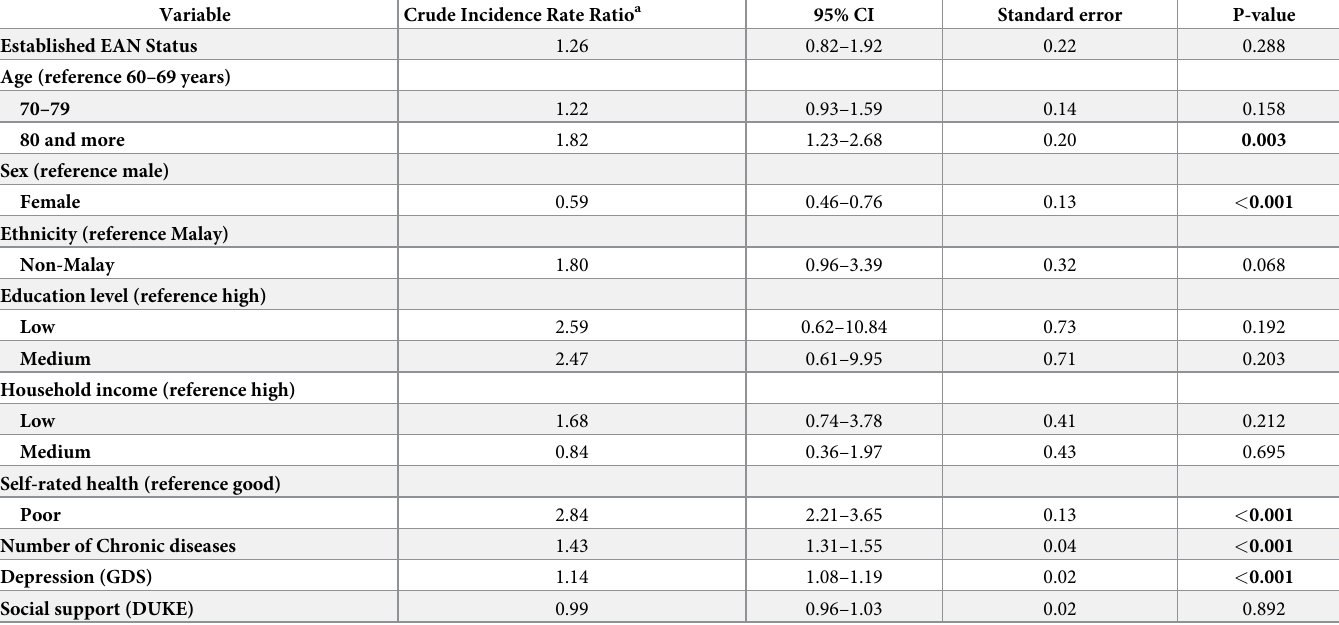
Table 3. Univariable regression table to show the association between EAN status and hospitalization.